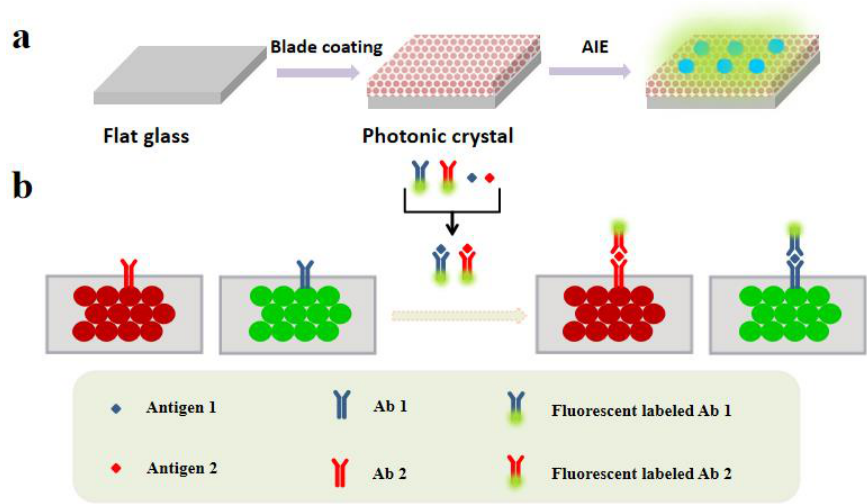
Figure 1. ( a ) Manufacturing process of AIEgens-doped PCs. ( b ) The procedure of multiplex detection based on the optical encoding property of the PCs.